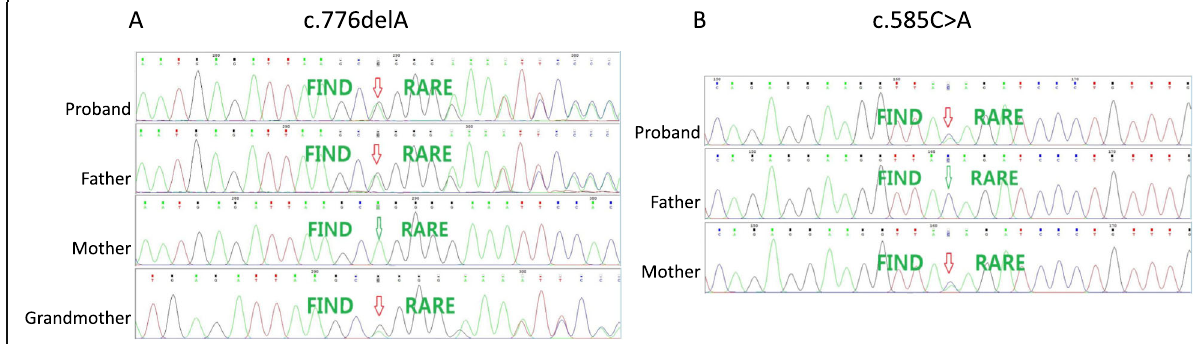
Fig. 2 Sanger validation of the compound heterozygous mutation in GIF gene